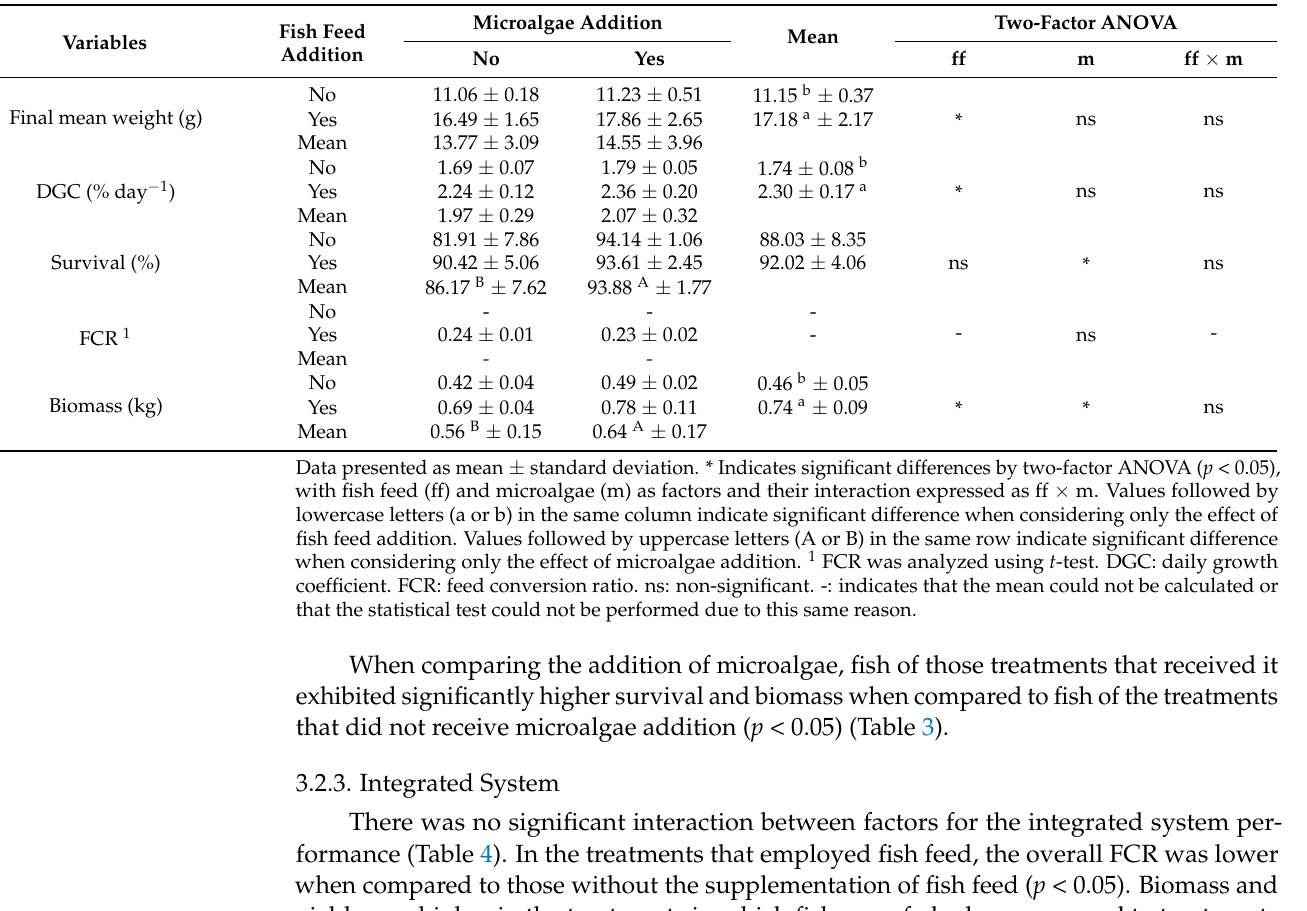
Table 3. Nile tilapia ( Oreochromis niloticus ) growth performance when reared in integration with Pacific white shrimp ( Litopenaeus vannamei ) using biofloc technology for 62 days, evaluating the addition of microalgae and fish feed in a factorial design. Partially presented in Vieira et al. [35].